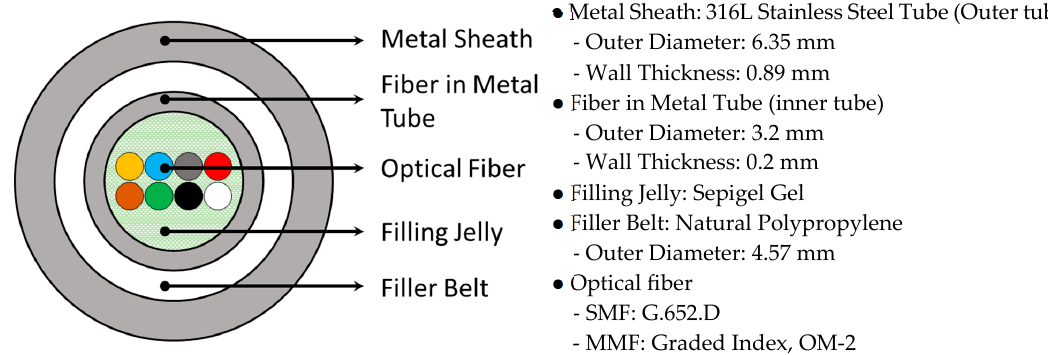
Figure 5. Optical fiber cable specifications.